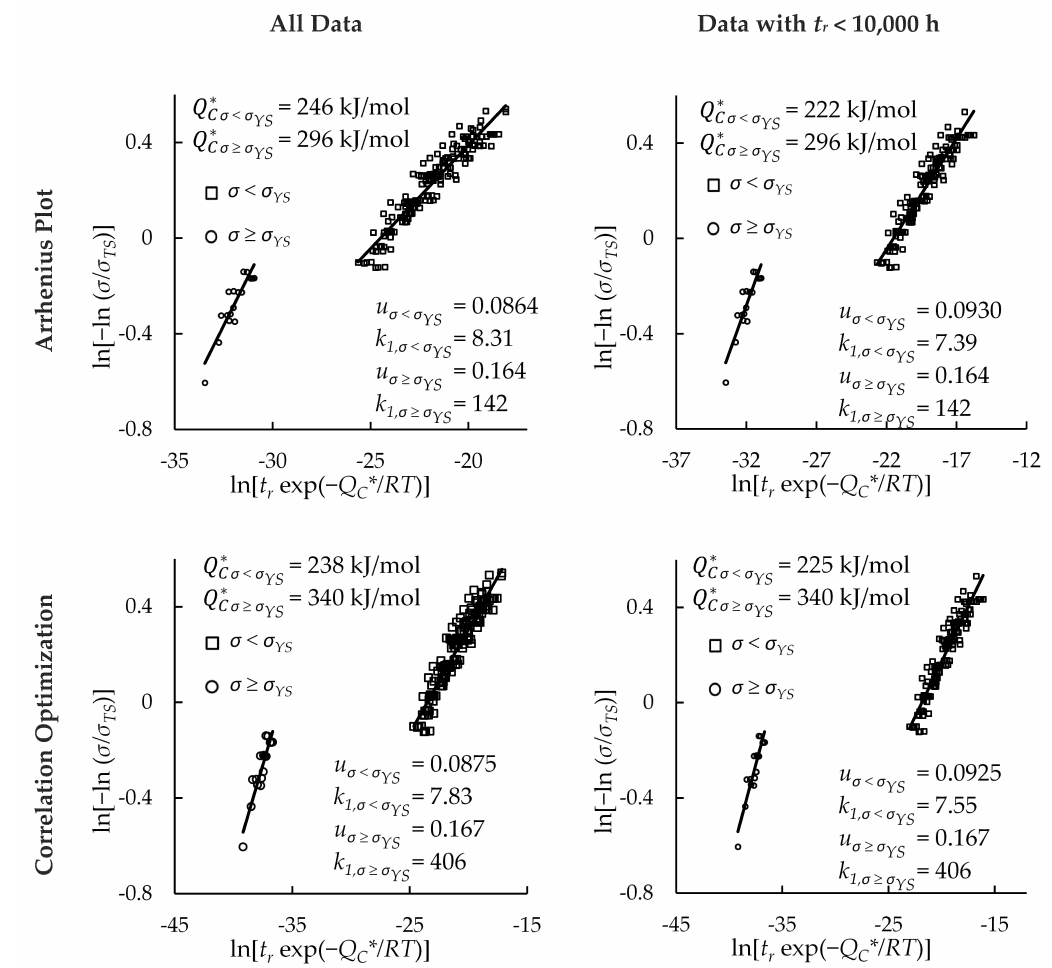
Figure A4. The effect of region-splitting on the goodness of fit of Wilshire plots for HR6W.